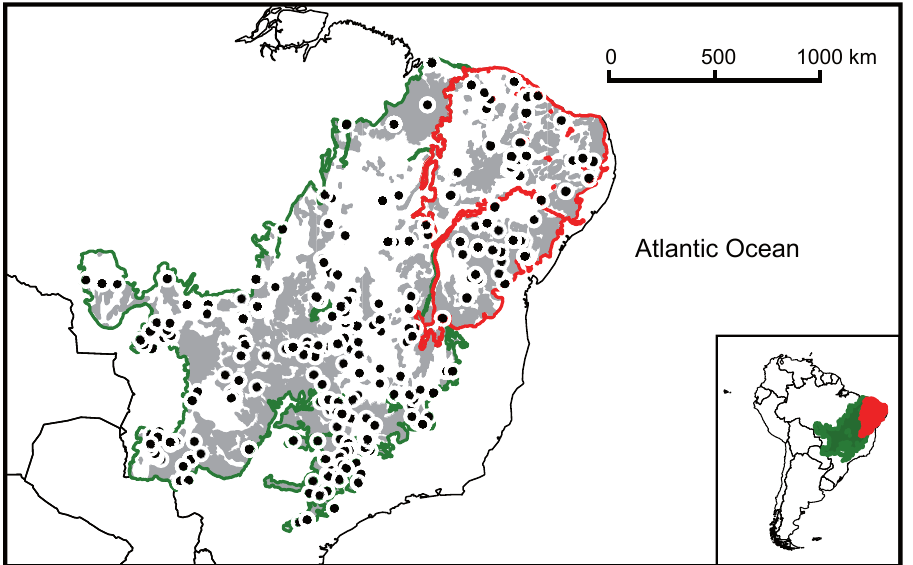
Figure 2. Sampling conducted for mammals and habitat lost due to human activities in the Caatinga and the Cerrado. Dots represent sites where sampling has been conducted according to data from the Global Information Biodiversity Facility (GBIF) and Ribeiro et al. (2010). These data represent a highly conservative proxy of the sampling conducted in these biomes (see Discussion). Areas in grey represent areas where habitat loss has occurred due to human activities. Borders of the Caatinga (red) and the Cer- rado (green) are restricted to Brazil (i.e., does not include the small portions of the Cerrado in Bolivia and Paraguay). The plotted data for habitat loss and biome borders were obtained from the Instituto Brasileiro de Geografia e Estatística